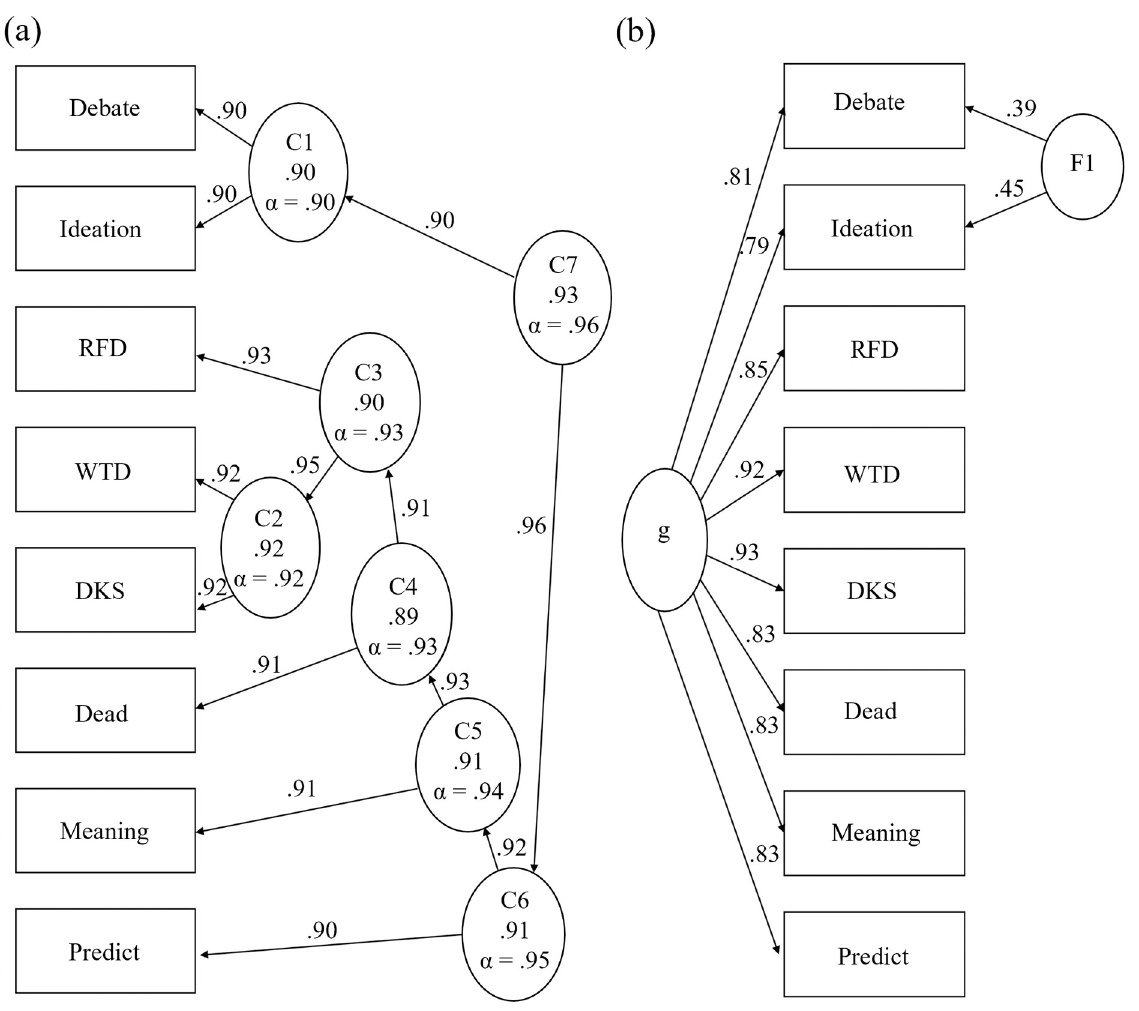
Fig 2. Hierarchical cluster analysis (left) and bifactor analysis (right) of the Suicidality Scale, (S1, N = 5,115). Ellipses represent assumed latent traits, rectangles represent observed traits (item responses), g = general factor, F = group factor.